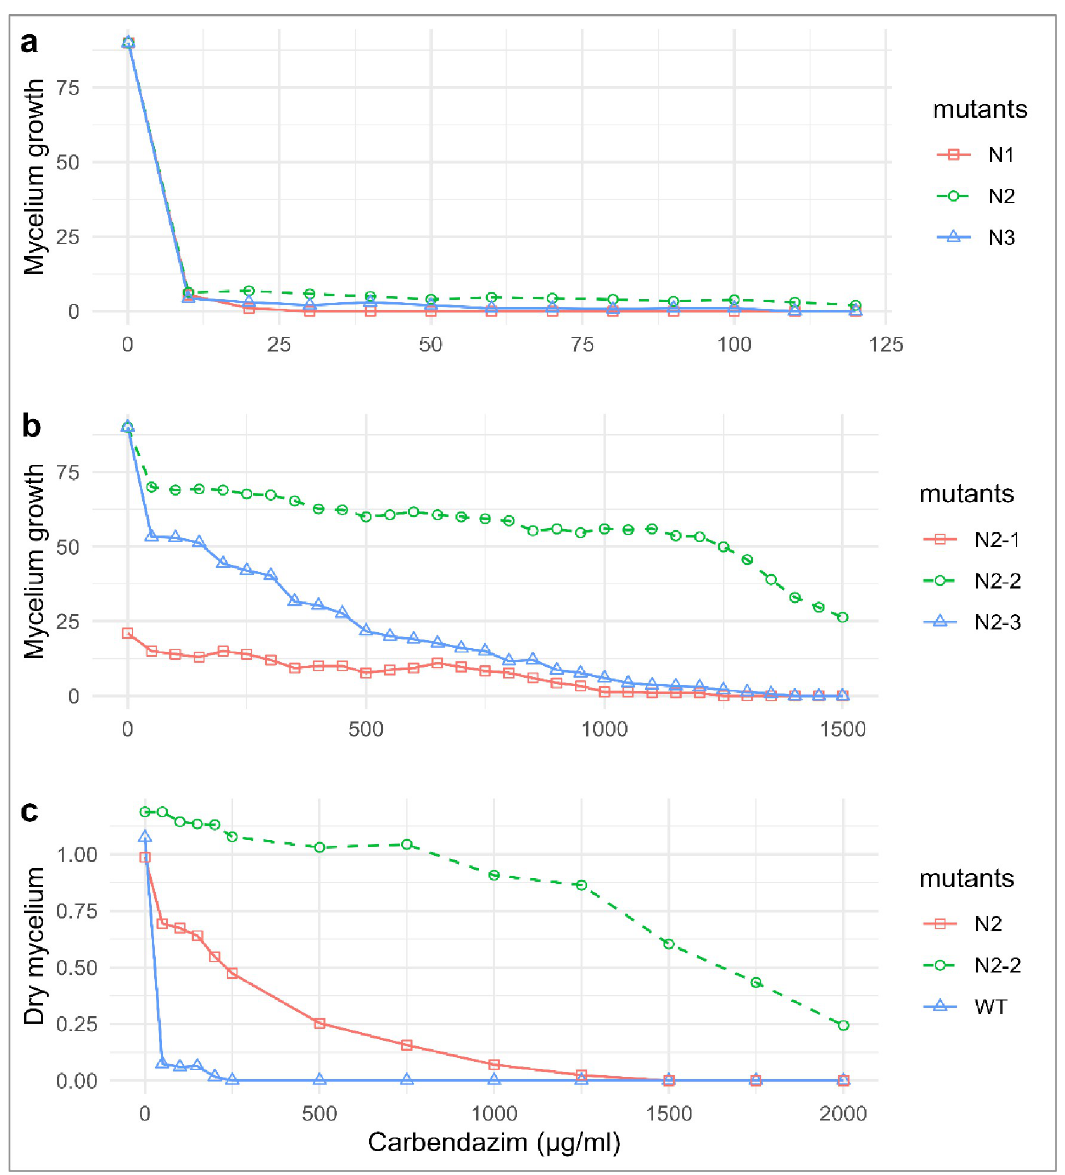
Fig 2. Carbendazim tolerance and dry mycelial productions in N-methyl-n-nitro-N-nitrosoguanidine irradiated Trichoderma mutants. (a) The 1 st round NTG induced N1, N2, N3 mutants carbendazim tolerance at 0–120 μ g/ml carbendazim amended PDA; (b) 2 st round NTG induced N2-1, N2-2, N2-3 mutants carbendazim tolerance at 0–1500 μ g/ml carbendazim amended PDA; (c) dry mycelium production ability of N2-2, N2 and WT in 0–2000 μ g/ml carbendazim amended potato dextrose